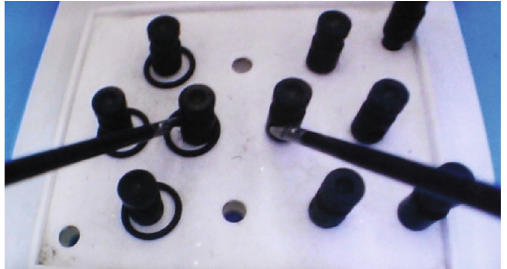
Figure 3: Transferring task. In this image, the straight instruments via LAP (Group D) are